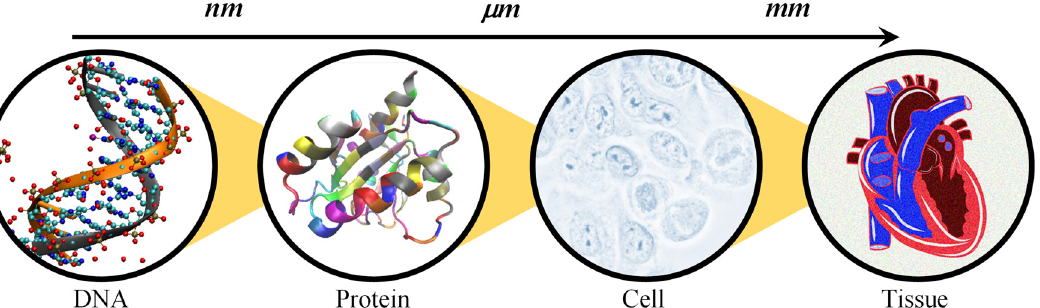
Figure 1: Structure of materials in life at di ff erent length scales. DNA is a long molecule within the cell nucleus at the nanoscale. Sections of DNA code for speci fi c proteins which are usually modeled from mesoscale. These proteins work in the cells which can be seen by a microscope. Groups of cells come together to form tissues, and tissues organize together for organs which are vital for human bodies at the